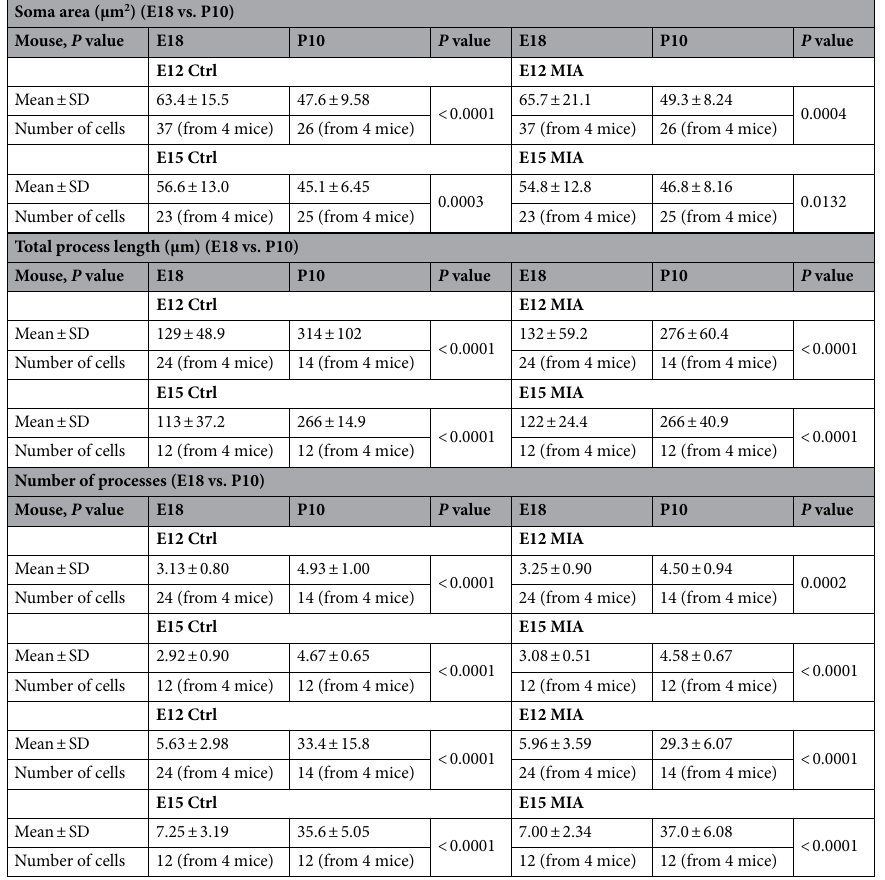
Table 9. Comparison of morphological properties between E18 and P10 microglia from control (E12 and E15 saline -injected) and MIA (E12 and E15 Poly(I:C) -injected)